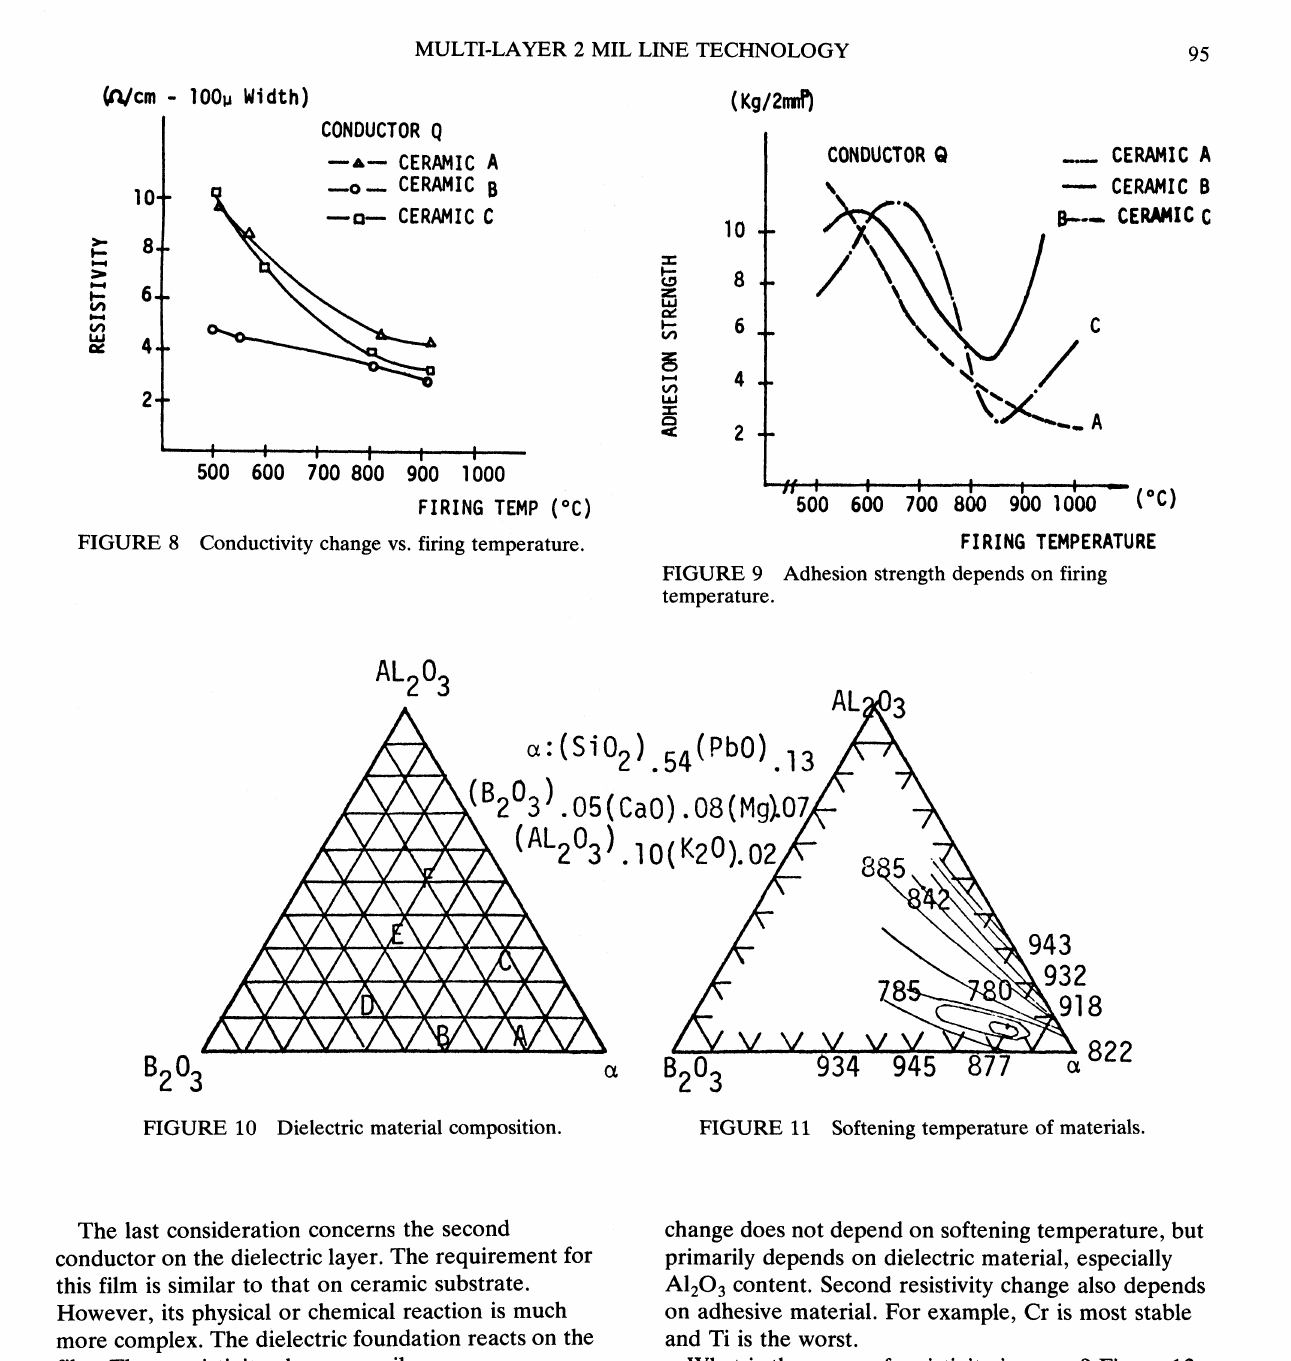
FIGURE 8 Conductivity change vs. firing temperature.